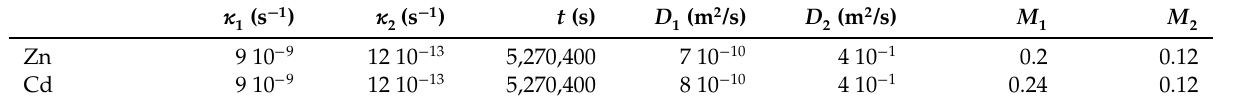
Table 1: Parameter values for Zn and Cd removal profile with pH variation in K4 after 61